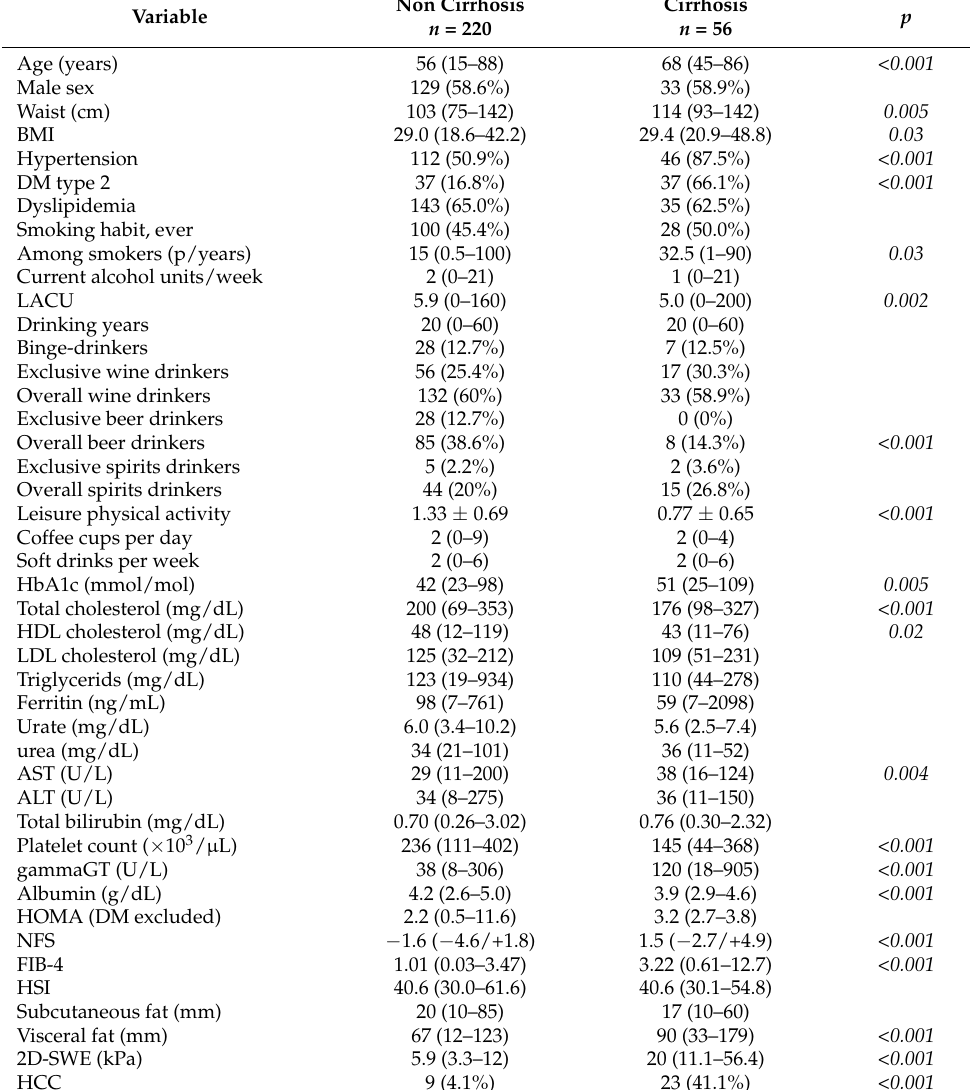
Table 5. Patient characteristics according to cirrhosis status (overall clinical evaluation).